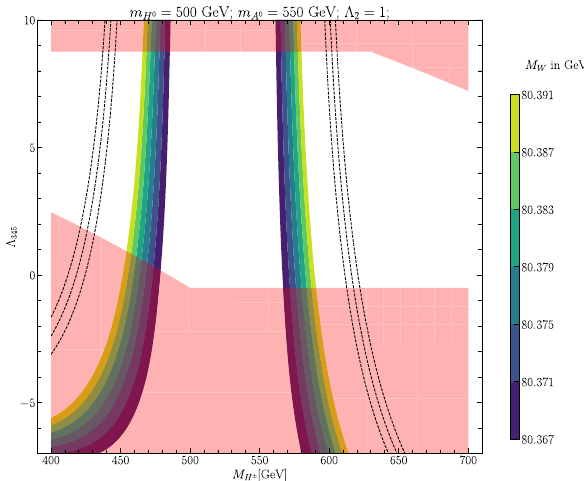
Fig. 5 Results in the IHDM in the m H ± – (cid:10) 345 plane. The bands indi- catetheparameterconfigurationsforwhichthecalculated M W iswithin the 1 σ uncertainties of the measured values; the PDG value refers to the coloured band and the CDF value to the dashed band. The red-shaded areas show the parameter regions that are excluded by vacuum stability and tree-level